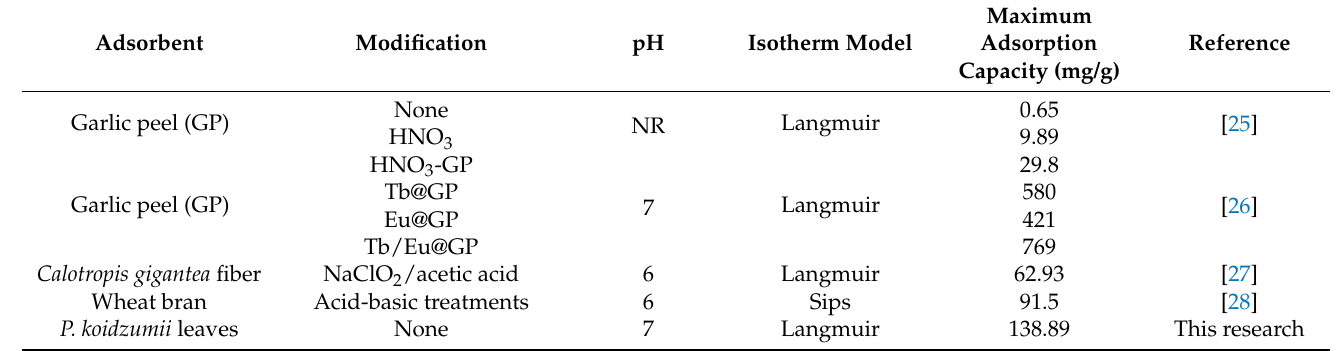
Table 4. Comparison of various studies for the adsorption of enrofloxacin onto some low-cost adsorbents.